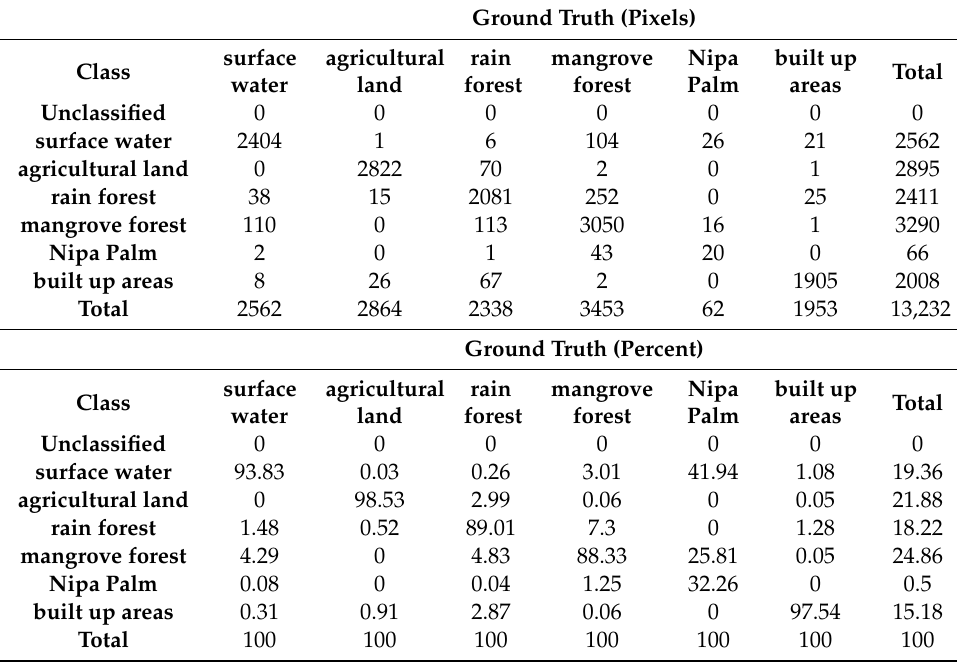
Table A1. Confusion Matrix of the 2017 SVM Polynomial kernel Land Cover Classification of the Niger Delta.